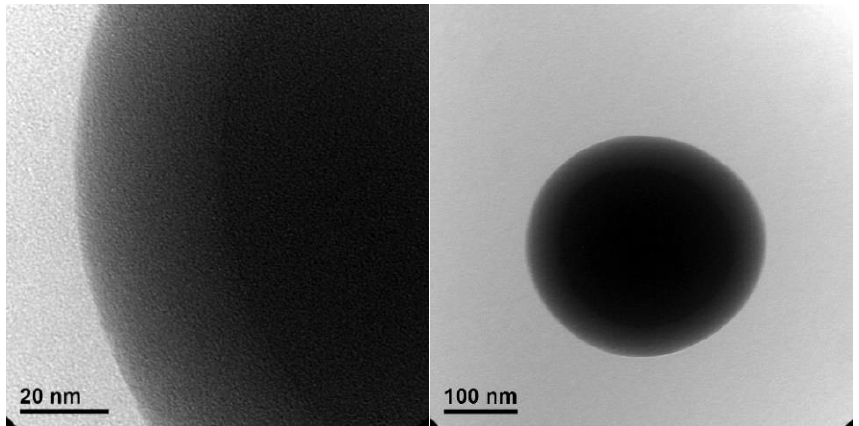
Figure 2. SEM image ( a ) and particle size distribution histogram ( b ) of the PMMA@P(MAA-co-EGDMA) core-shell copolymer.